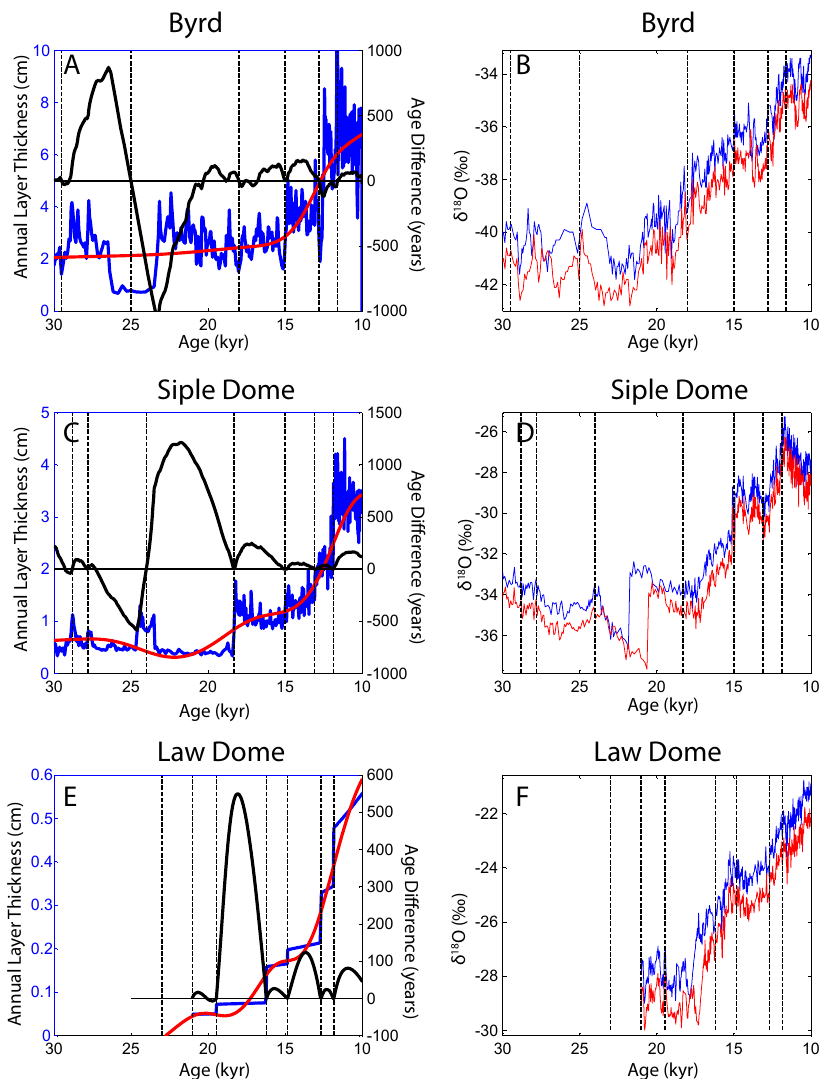
Figure 7. Annual-layer thicknesses of original timescales (blue) and ALT interpolation (red) in (A) , (C) , and (E) . Age differences are shown in black on the original timescale. The stable-isotope records on the original (blue) and ALT (red) timescales are shown in (B) , (D) , and (F) . The stable-isotope records on the ALT timescales are shifted down by